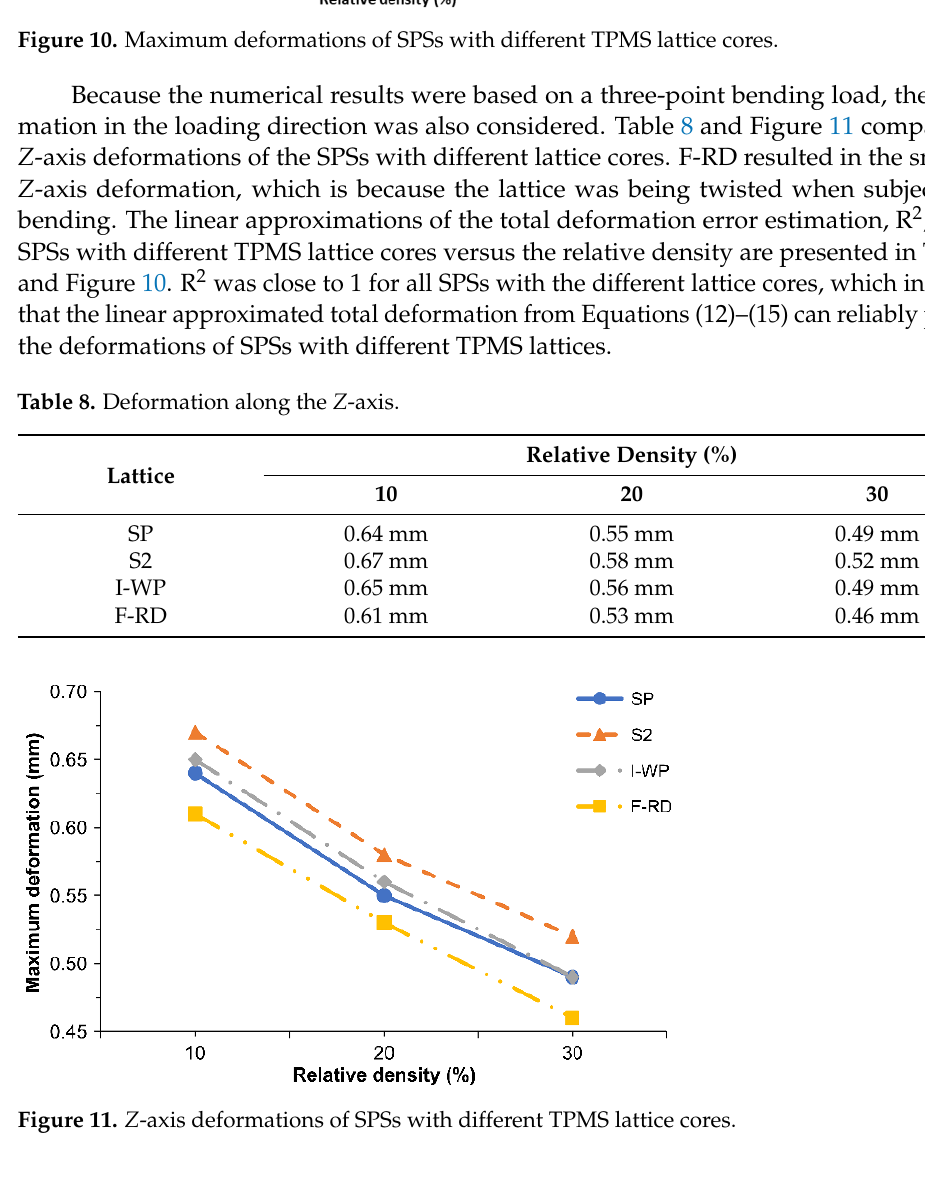
Figure 10. Maximum deformations of SPSs with different TPMS lattice cores.